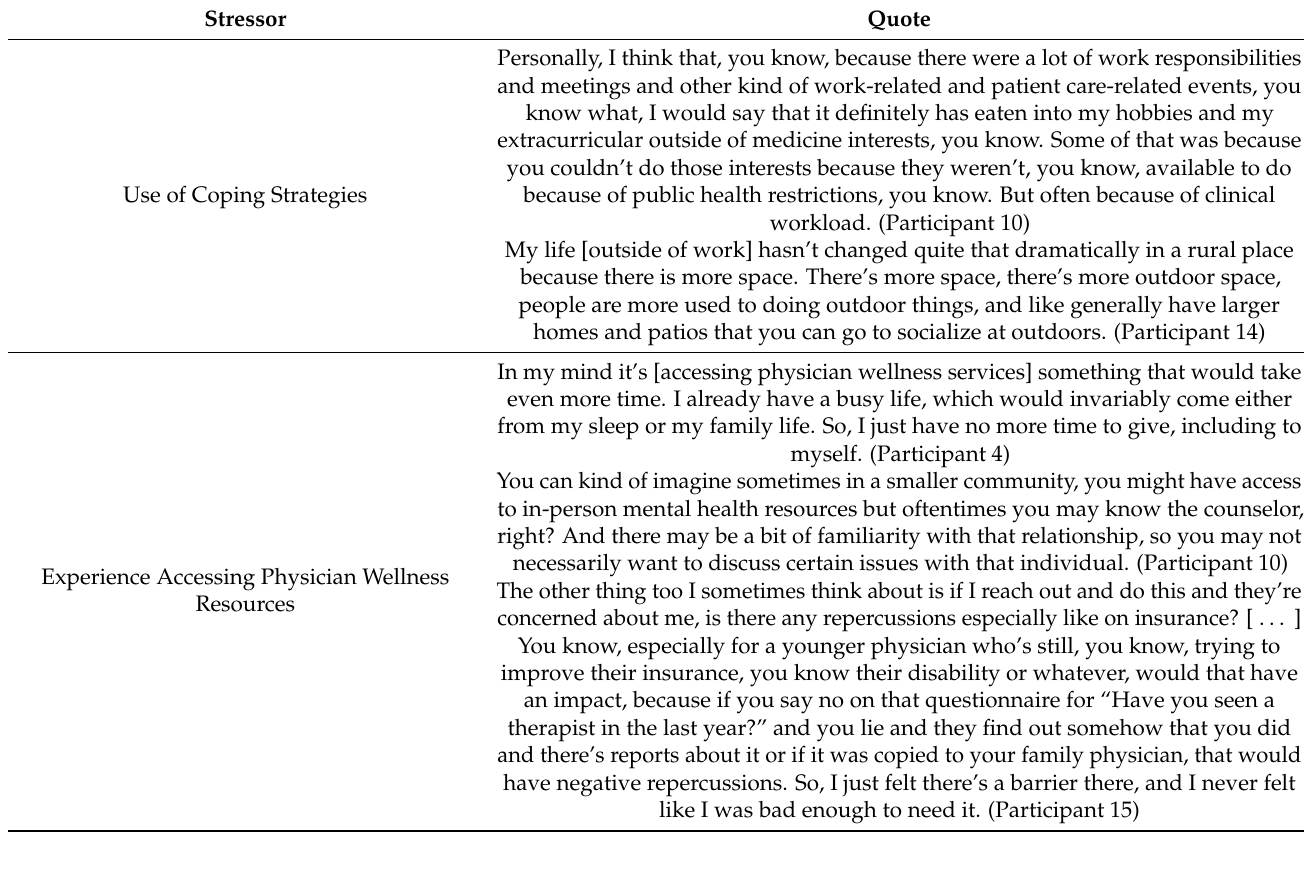
Table A4. Quotes from participants about coping with the COVID-19